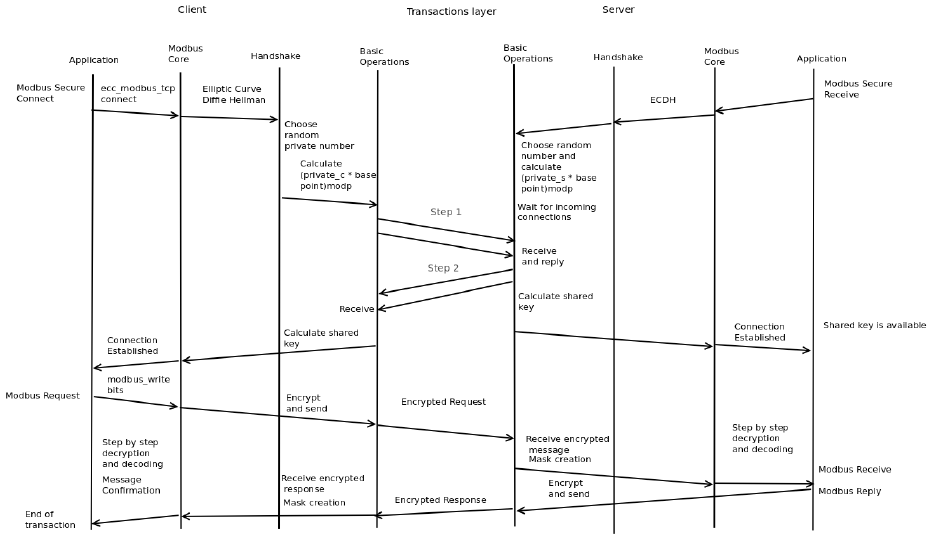
Figure 4. Time-sequence diagram for the library operations.